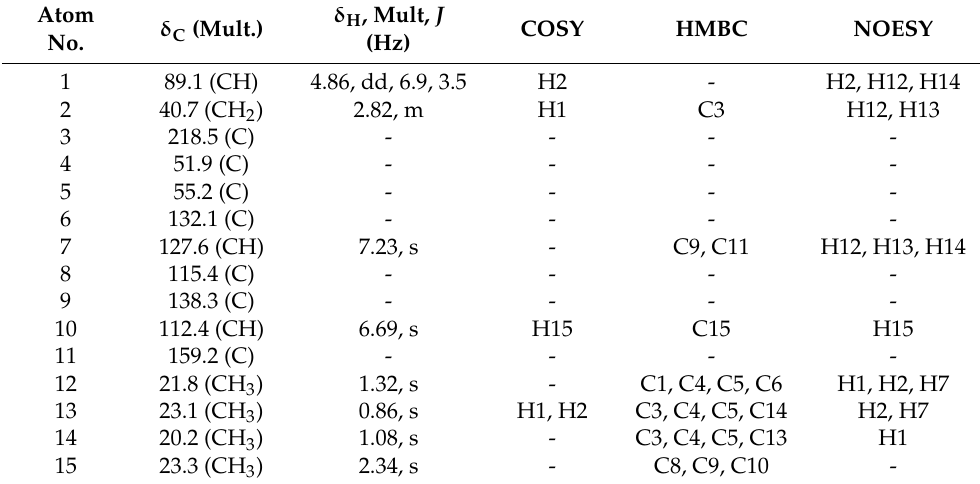
Table 3. NMR spectroscopic data for compound 7 .